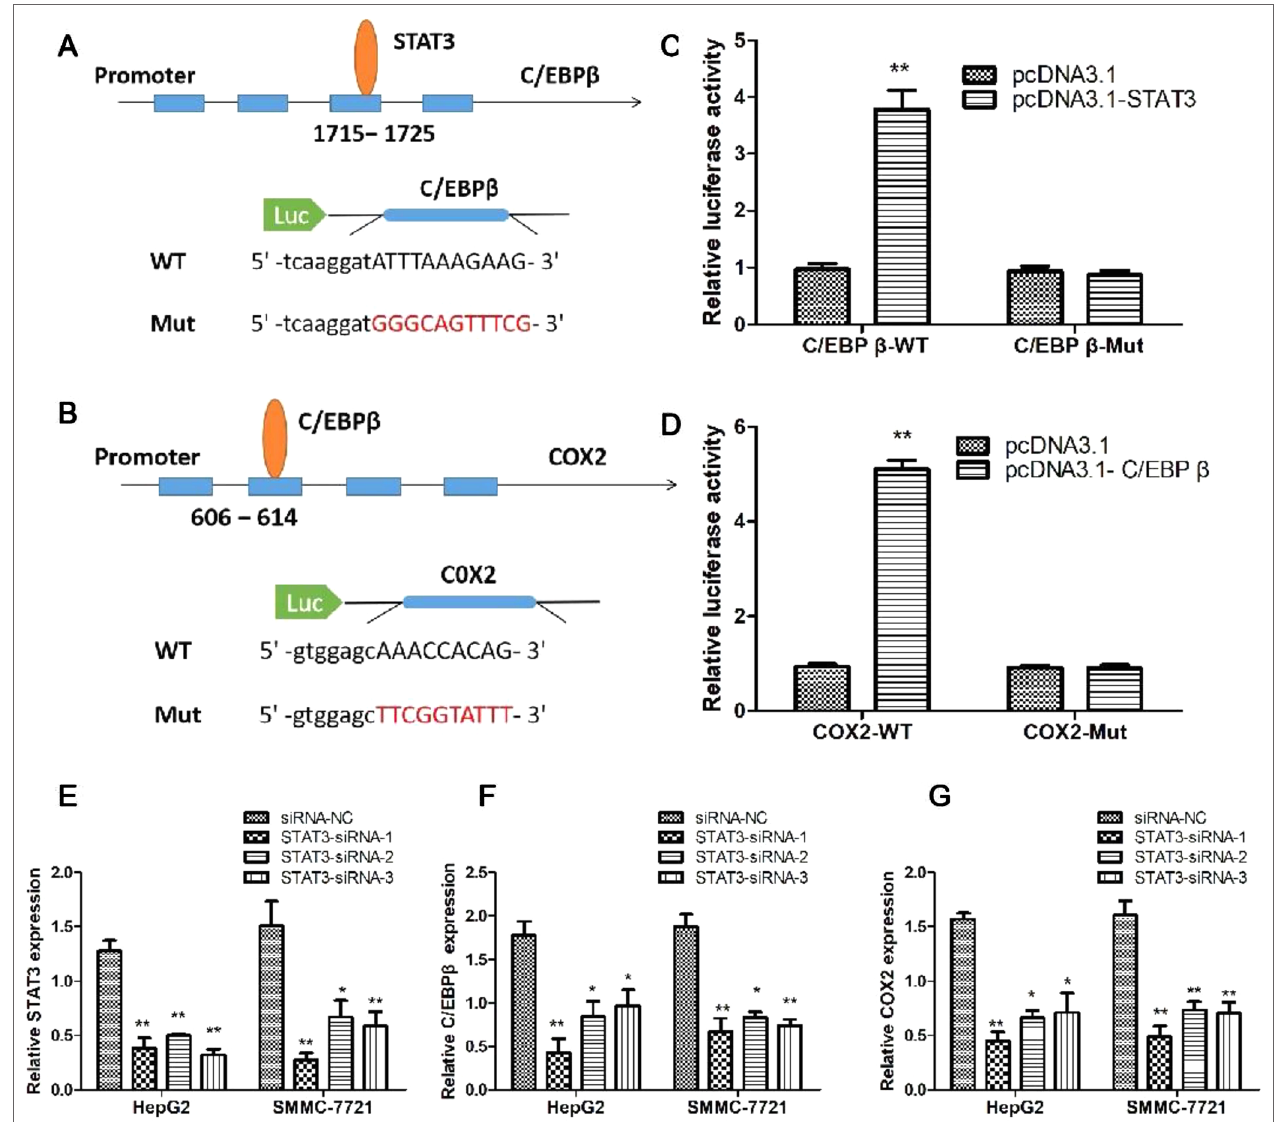
FIGURE 7 | STAT3/C/EBP β signaling pathway regulates the expression of COX2 in HCC cells. Schematic illustrating the STAT3 binding sites at the promoter of C/EBP β (A) and the C/EBP β binding sites at the promoter of COX2 (B) . (C) Luciferase reporter assay was applied to verify the targeted binding effect between STAT3 and C/ EBP β . ** P < 0.01. (D) Luciferase reporter assay was applied to verify the targeted binding effect between C/EBP β and COX2. ** P < 0.01. (E) qRT-PCR analysis of STAT3 expression following transfected HepG2 and SMMC-7721 cells with STAT3-siRNA1-3. * P < 0.05, ** P < 0.01. (F) qRT-PCR analysis of C/EBP β expression following transfected HepG2 and SMMC-7721 cells with STAT3-siRNA1-3. * P < 0.05, ** P < 0.01. (G) qRT-PCR analysis of COX2 expression following transfected HepG2 and SMMC-7721 cells with STAT3-siRNA1-3. * P < 0.05, ** P <